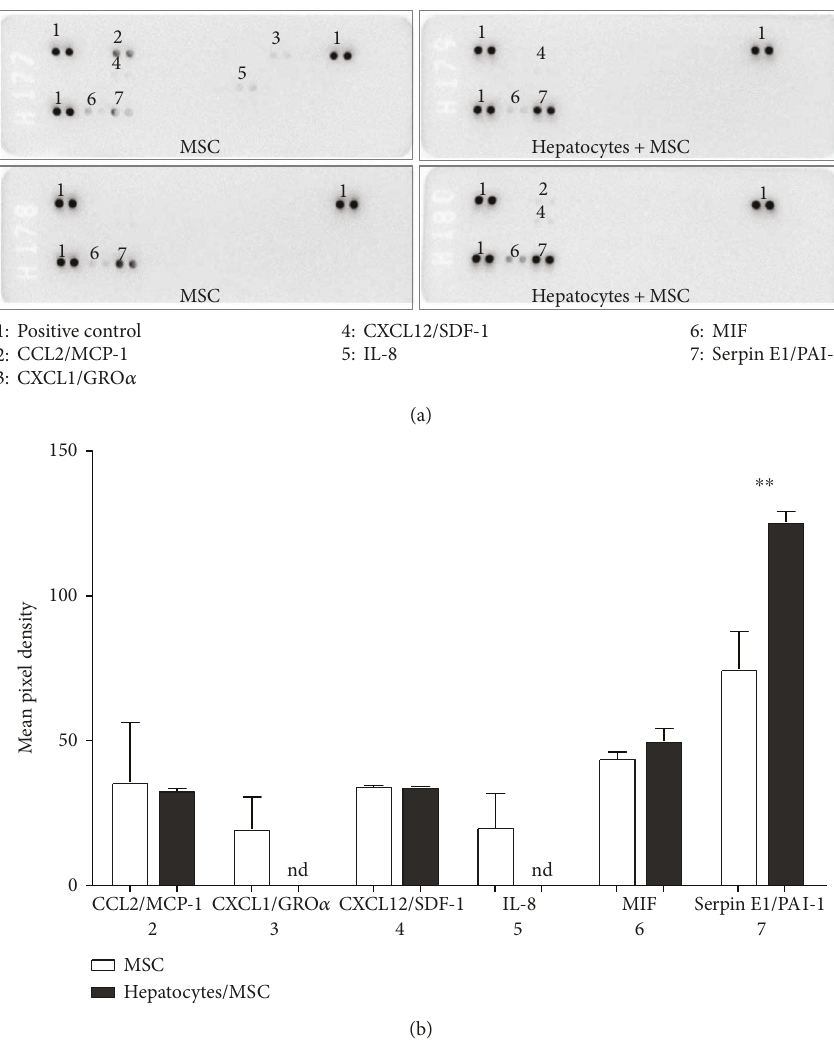
Figure 9: Pro fi ling of human cytokines using cell culture supernatants of MSC alone and MSC cocultured with hepatocytes. (a) Human cytokines were analyzed using antibody membranes in MSC alone and MSC cocultured with hepatocytes (0.2 × 10 6 cells/mL/24-well plate) obtained from 2 di ff erent donors. (b) Spots were quanti fi ed using ImageJ and expressed as mean pixel density. Cytokines secreted from MSC cultured alone (white bars) and cytokines secreted from MSC cocultured with hepatocytes (black bars). ∗∗ p < 0 01